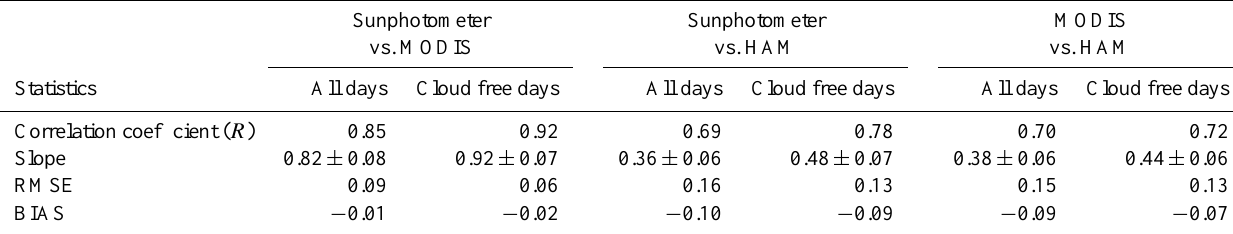
Table 3. Linear regression statistics between the ship-based remote sensing measurements, MODIS observations and model-simulated AODs during Bay of Bengal and Arabian Sea cruise